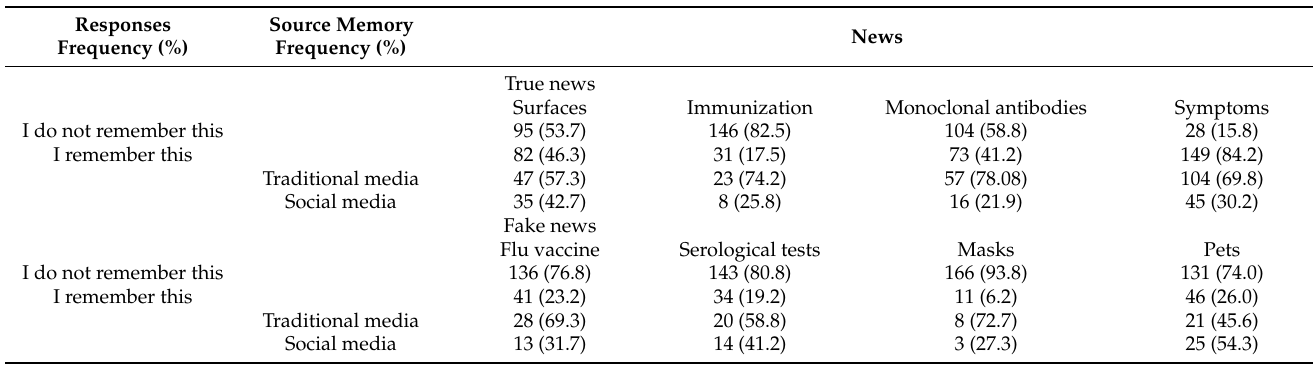
Table 2. Response rates for true and fake news and source types for the recalled news.